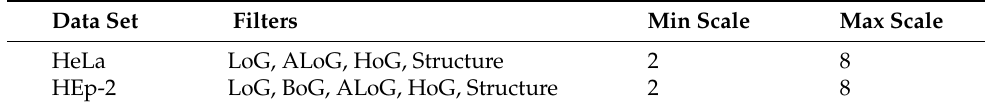
Table 5. Scale space filters and scales used for Hela and HEp-2 data sets.